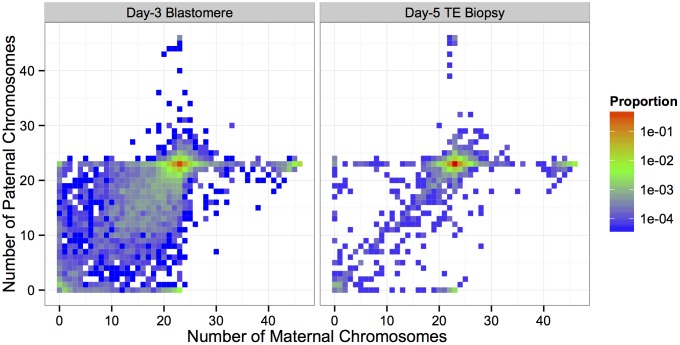
Heat maps depicted proportions of biopsies with different configurations of maternal and paternal chromosomes.Minor aneuploidies and triploidies disproportionately involved maternal homologs. The paternal genome is absent from the majority of haploid embryos. Sub-diploid complements with missing maternal and paternal homologs were common in day-3 blastomere biopsies, but strongly depleted in day-5 TE biopsies. This results in a ‘steeper’ heat map surface for day-5 biopsies, centered on the euploid complement.